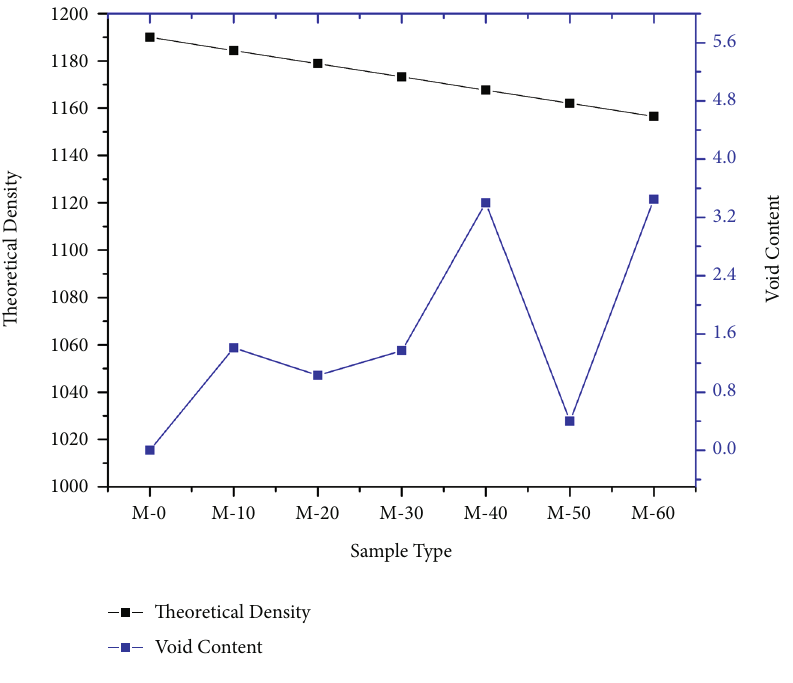
Figure 8: Theoretical density and void content of di ff erent sample types.